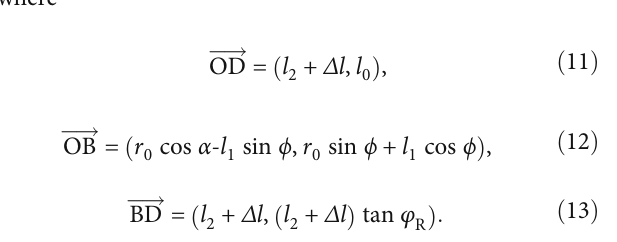
ϕ τ L and R at various